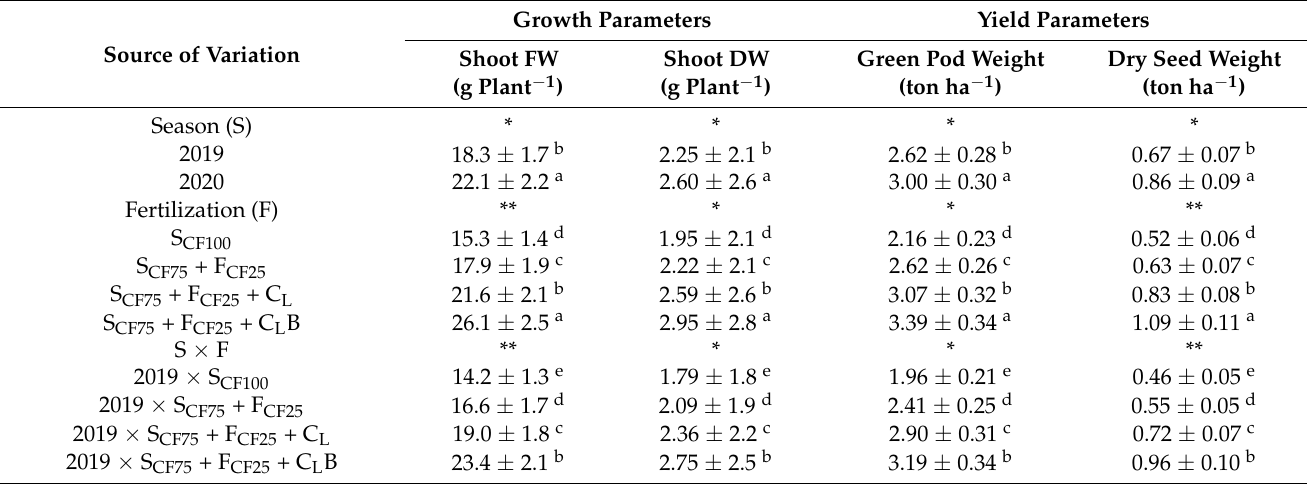
Table 4. Response of growth and productivity of Phaseolus vulgaris plants to growing season (2019 and 2020) and different fertilization strategies applied to virgin sandy